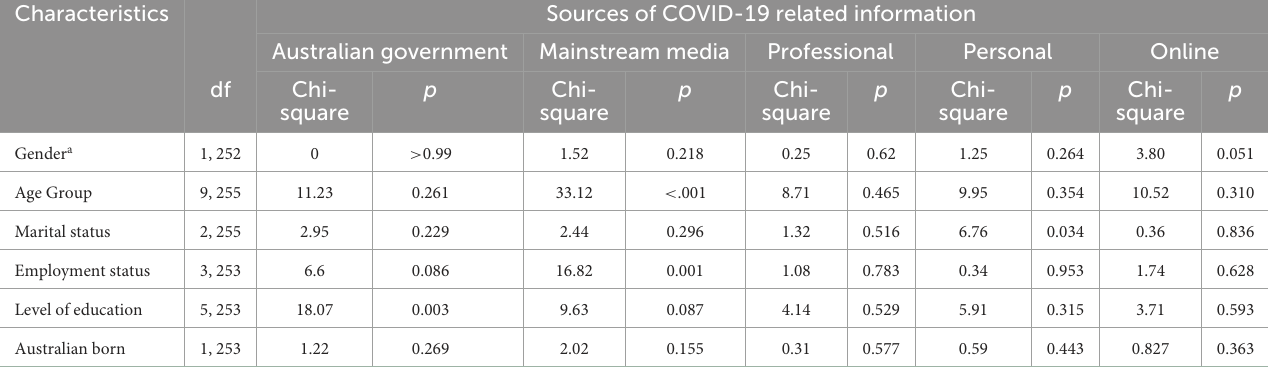
TABLE 2 Chi-square values for comparisons between use (vs. not) of top five sources of information by key participant characteristics ( n = 255).